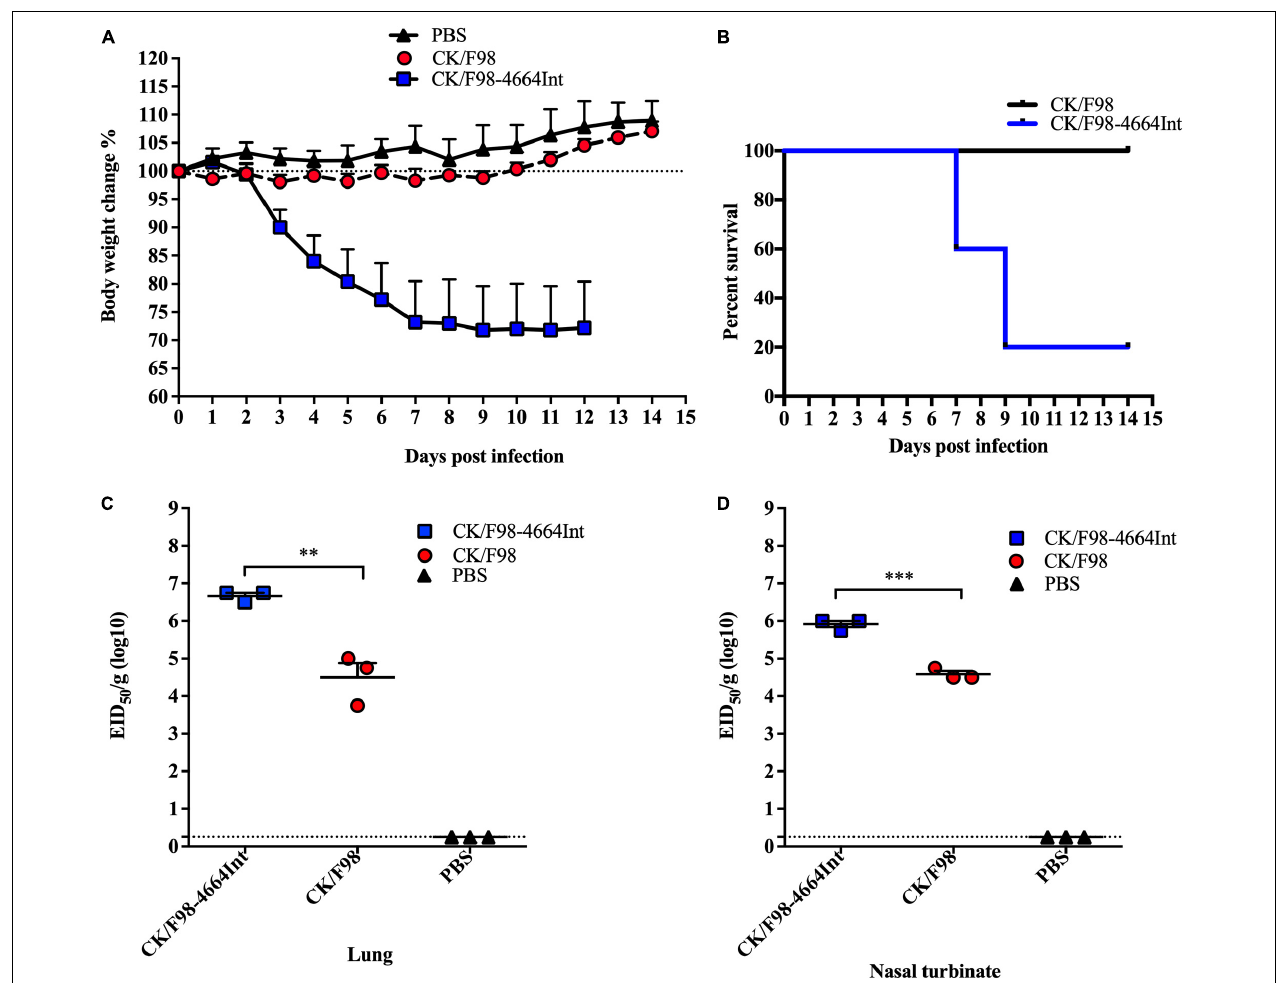
FIGURE 4 | Acquisition of the internal gene constellation of H7N9 virus resulted in enhanced pathogenicity and replication of H9N2 virus in mouse. Mice were intranasally inoculated with a single dose of 10 6 EID 50 of the parental H9N2 CK/F98 virus or the CK/F98-4664Int virus with the six internal genes derived from H7N9 SH/4664 virus. (A) Weight loss during a 14-day observation period. (B) Survival curve during a 14-day-observation period. Mice that lost > 25% of their pre-inoculated weight were regarded as dead and euthanized. (C) Virus titers in animal lungs, as determined by EID50 using MDCK cells. (D) Virus titers in animal nasal turbinates, as determined by EID50 using MDCK cells. n = 3 for each group. Data are expressed as mean ± SEM. P < 0.05, ** P < 0.01, and *** P < 0.001 by one-way